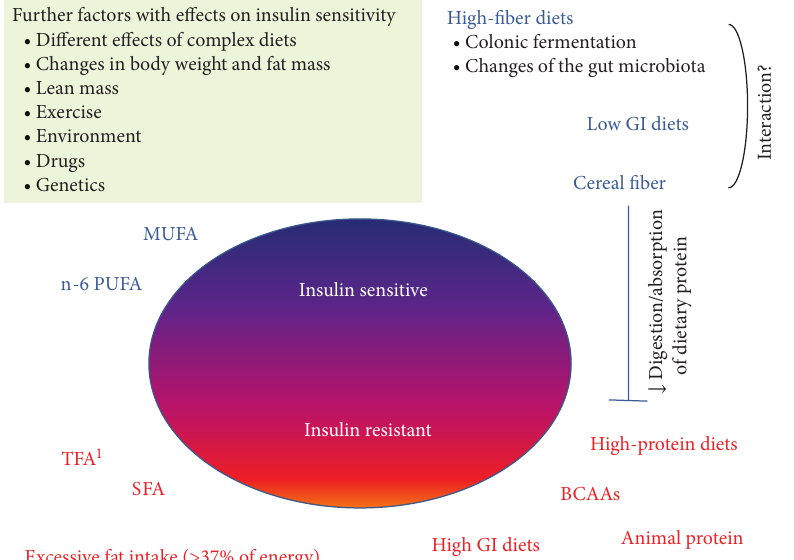
F 1: Dietary concepts using modulation of macronutrient composition without energy restriction. ere appear to be relevant interspecies differences when comparing metabolic effects of speci�c fatty acids. For example, in humans, n-6 PUFA may improve insulin resistance and diabetes risk, whereas n-3 PUFA from marine origin improve insulin sensitivity in rodent models but not in humans. No long- term-randomizedtrialshavebeenpublishedtodatethatinvestigatedtheeffectofdietaryfatcompositionondiabetesrisk.High-�berdietsand particularly diets high in insoluble cereal �ber appear to improve whole-body insulin sensitivity, possibly by interference with the digestion and/or absorption of dietary protein and as such preventing the amino-acid-induced activation of the mTOR/S6K1 signalling pathway. Separating the effects of high-�ber diets from potentially independent effects of diets varying in the glycemic index (GI) is challenging. In rodents, changes in the composition of the gut microbiota and colonic fermentation with the production of short chain fatty acids (SCFA) appear to be involved, but it remains to be shown whether this applies also in humans. Adverse effects of high-protein diets on insulin sensitivity may be partly compensated by satiating effects of dietary protein and consequent weight loss, and increases in lean mass, but long- term maintenance of weight loss with any diet appears to be difficult to achieve. MUFA, monounsaturated fatty acids; PUFA, polyunsaturated fatty acids; TFA, trans unsaturated fatty acids; SFA, saturated fatty acids; GI, glycemic index; BCAA, branched chain amino